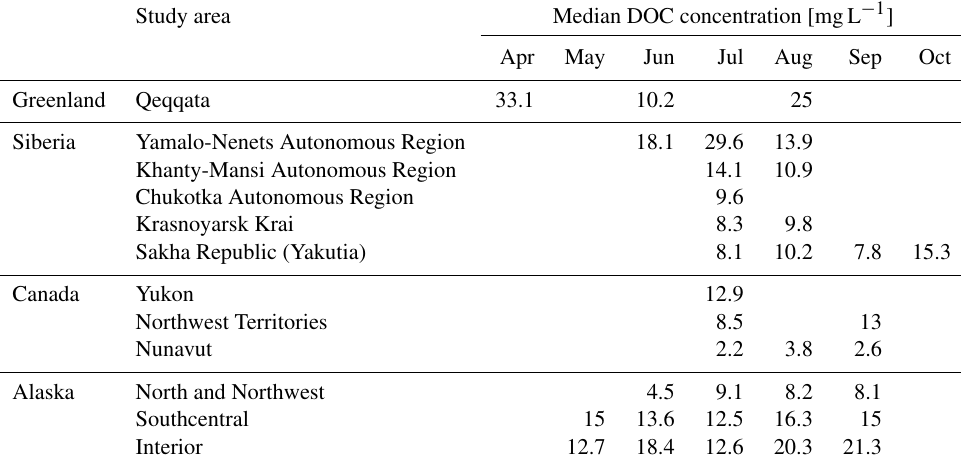
Table A2. Overview of median DOC concentration according to sampling months, where sampling month could be clearly